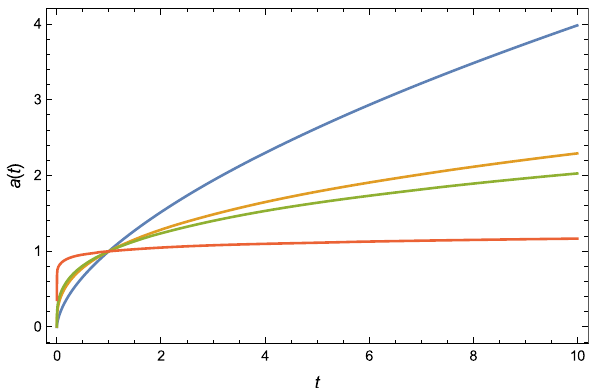
Fig. 13 Evolution of the scale factor with time for V (φ) = V 0 α e αφ , with the fixed value V 0 = 1, and varying α with the following values.